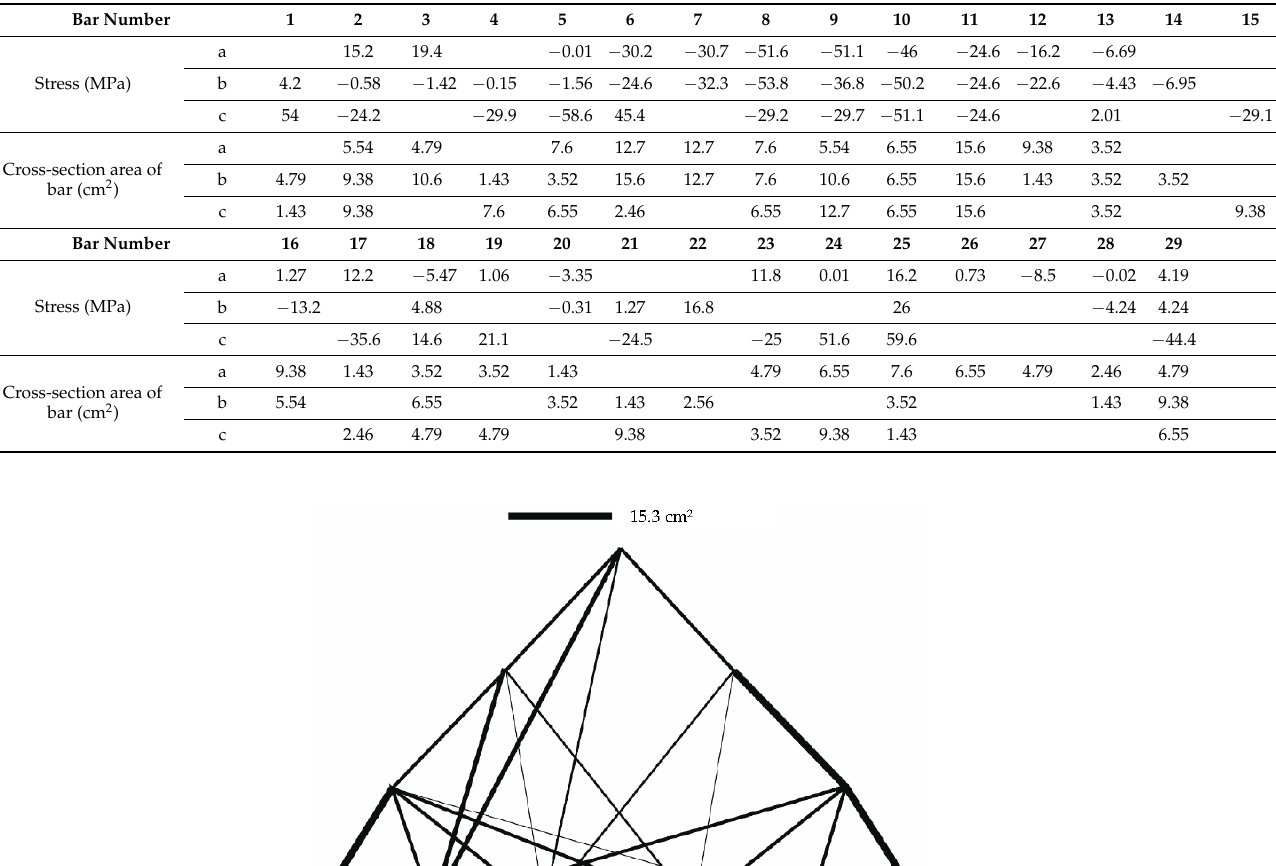
The results of the optimization are given in Table 4. Graphical outputs displaying individual cases are shown in Figures 7–9. Table 4. Stresses and cross-sectional areas in bars of an initial 29 bar structure, state after optimization.